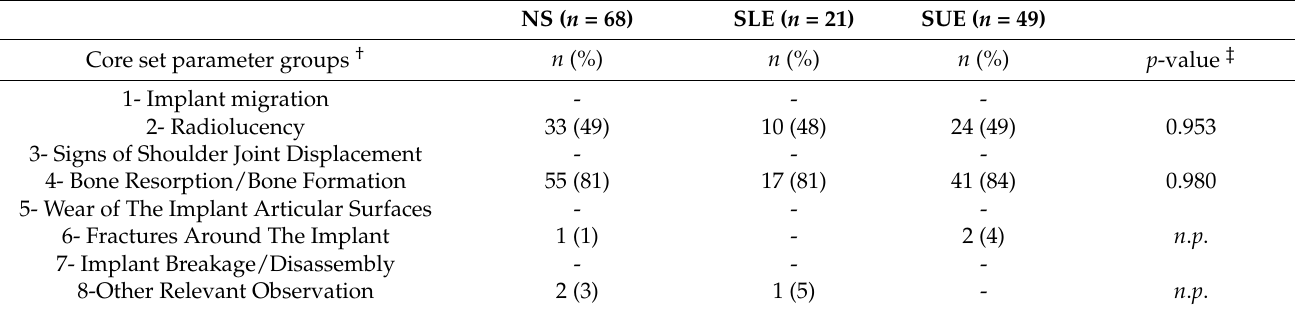
Table 3. Radiological parameters 5 years after RSA